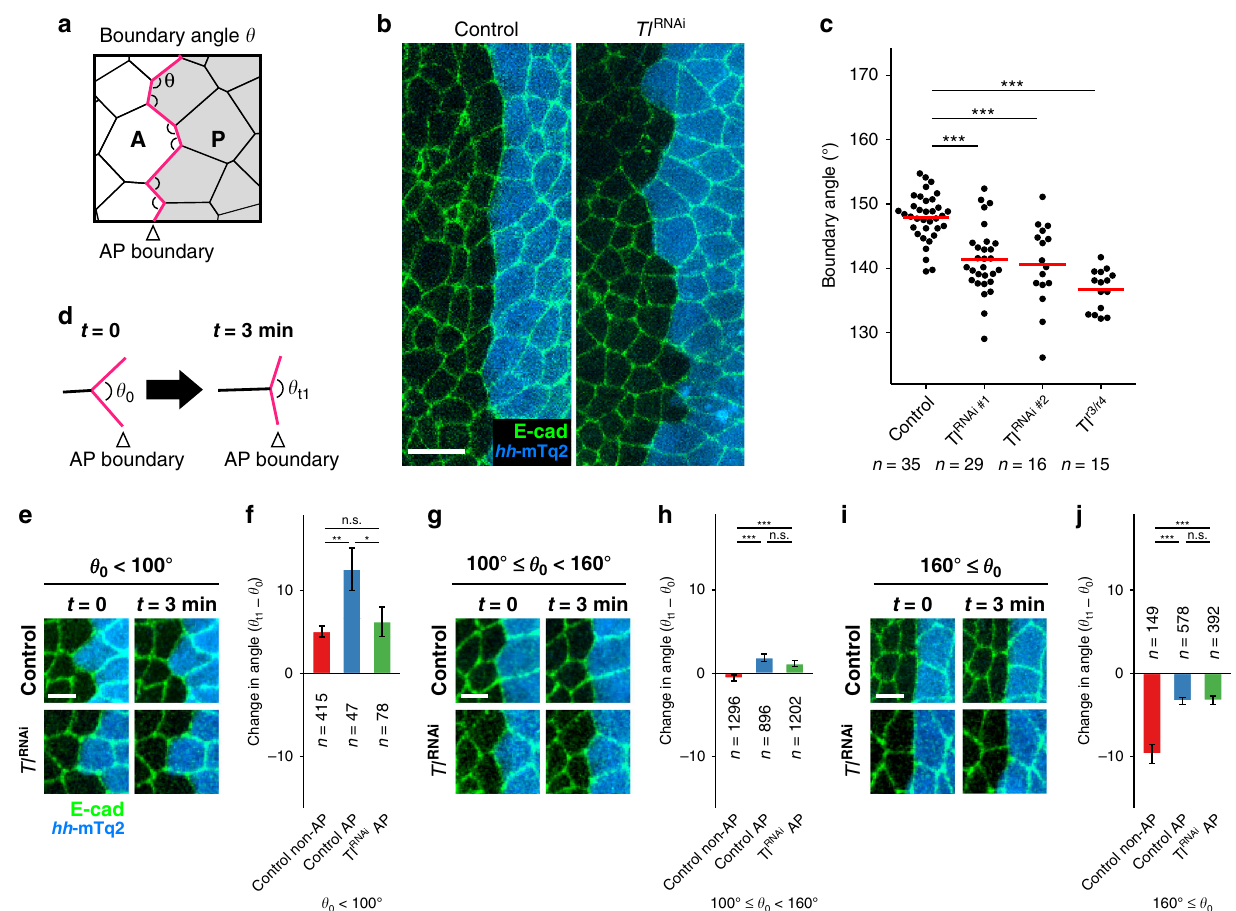
Fig. 2 Toll-1 is required for maintaining the sharp histoblast AP boundary. a Schematic representation of boundary angle measurement. The boundary angle θ is de fi ned as the angle made by a pair of neighboring cell junctions on the AP boundary. b The AP boundaries in control (left, 23 hAPF) and Tl knockdown (right, 23 hAPF) histoblasts by expressing a short hairpin RNA for Tl using a histoblast-speci fi c GAL4 driver, esg -GAL4. Scale bar: 10 μ m. c Quanti fi cation of the boundary angle in control, Tl knockdown, and Tl mutant tissues as a readout for the sharpness of the AP boundaries. n = 35, 29, 16, and 15 boundaries for Control, Tl RNAi #1 , Tl RNAi #2 , and Tl r3/r4 , respectively. Images were analyzed at the proliferation phase (22 – 24 hAPF). Statistical signi fi cances were evaluated using a Student ’ s t test (unpaired, two-sided). *** p < 0.001. d Diagram illustrating the measured boundary angle for the quanti fi cation of boundary angle change shown in ( e – j ). e – j Cellular con fi guration-dependent dynamics of the boundary angle change. Boundary angle ( θ 1 ) change over 3 min for the pair of junctions that form the boundary angle ( θ 0 ) less than 100 ˚ ( e ), between 100 ˚ and 160 ˚ ( g ), and more than 160 ˚ ( i ) 3 min before the measurement in the control and Tl knockdown tissues and the quanti fi cation of the boundary angle change ( f , h , and j ). Scale bars: 5 μ m. Numbers of analyzed vertices ( n ) were indicated in graphs. Data were collected from two animals (22 – 24 hAPF, proliferation phase) for each experiment. Data are presented as mean values ± SEM. Statistical signi fi cance was evaluated using a Student ’ s t test (unpaired, two-sided). * p < 0.05, ** p < 0.01, and *** p <